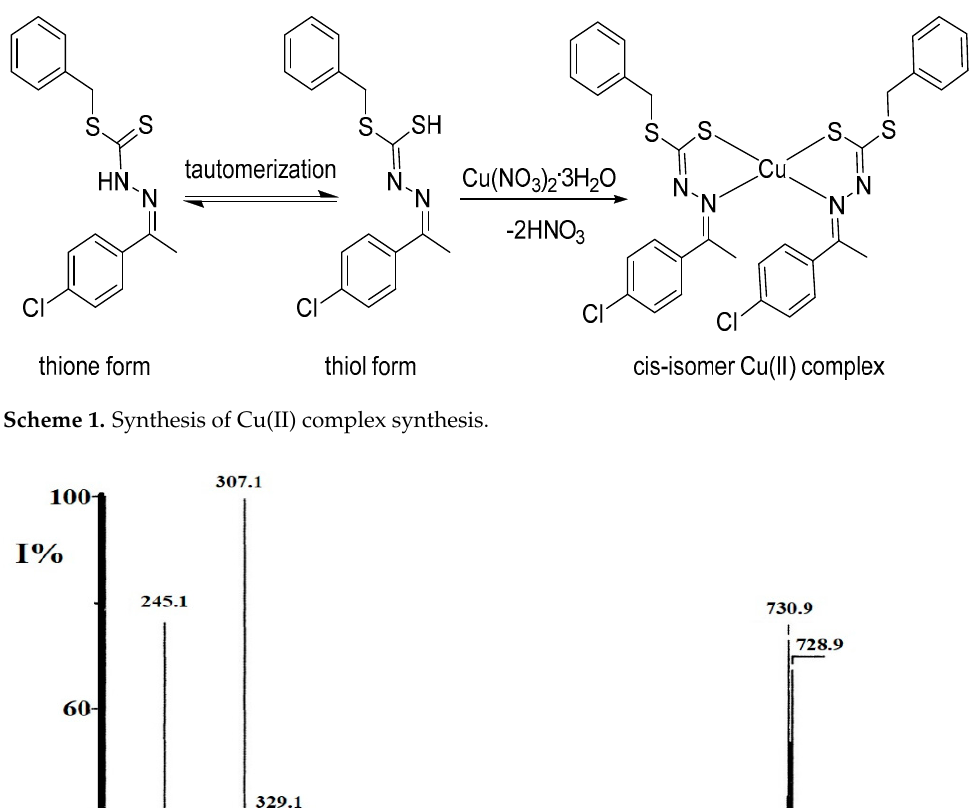
Figure 1. FAB-MS of the desired Cu(II) complex.